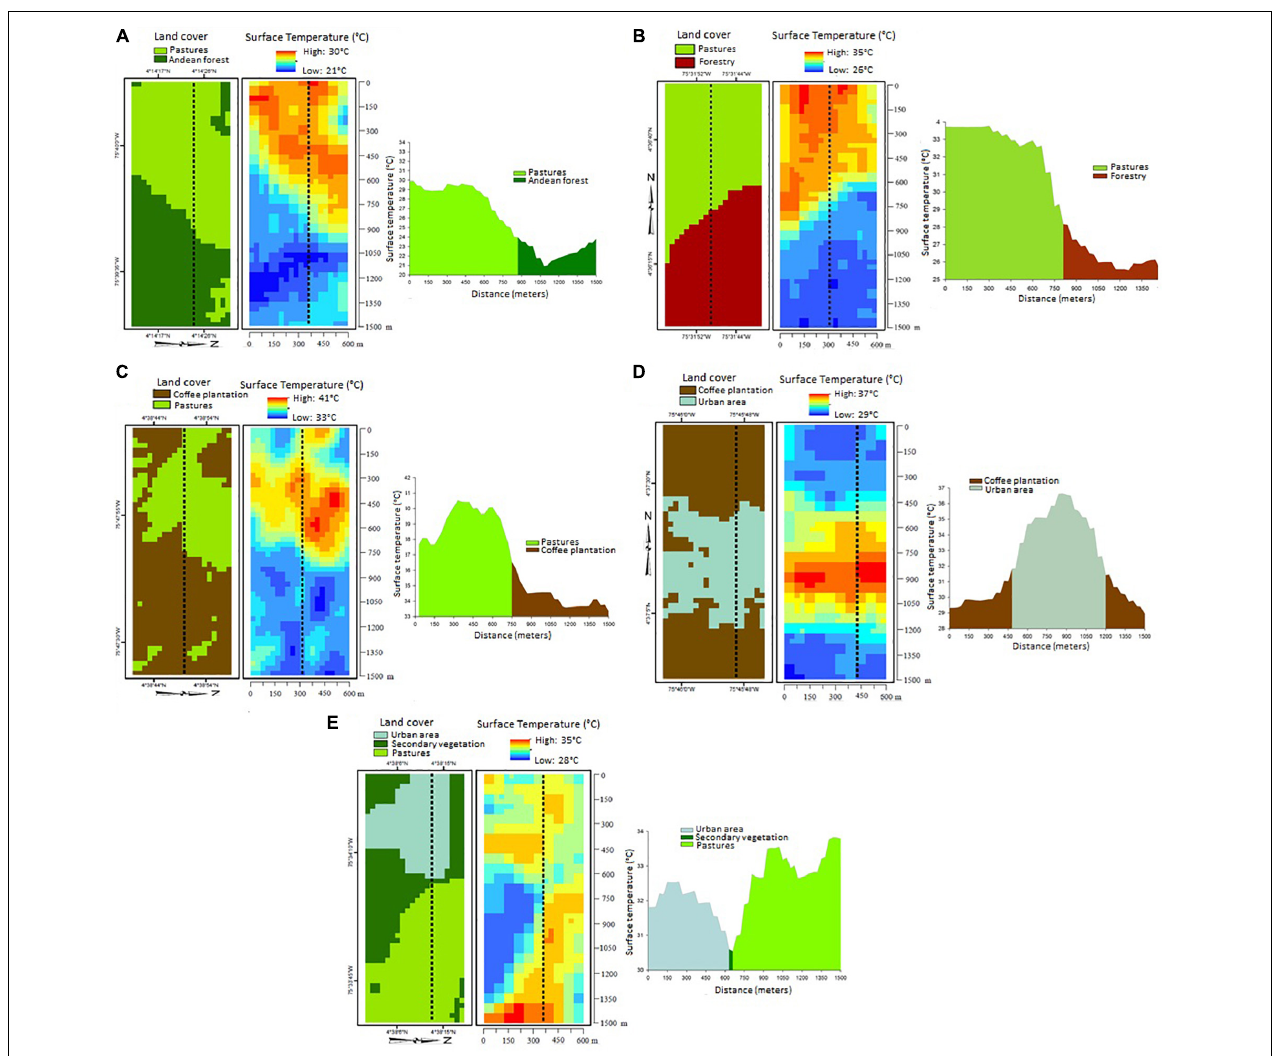
FIGURE 6 | Types of land use and land cover (left) and profiles of surface temperature (right) along the dark dotted line. Note the temperature differences between land use transitions: (A) pastures – natural Andean forest; (B) pastures – forestry; (C) coffee plantations – pastures; (D) coffee – urban area; (E) urban area – secondary vegetation – pastures. Adapted from Carvajal-Vanegas and Pabón-Caicedo (2014).